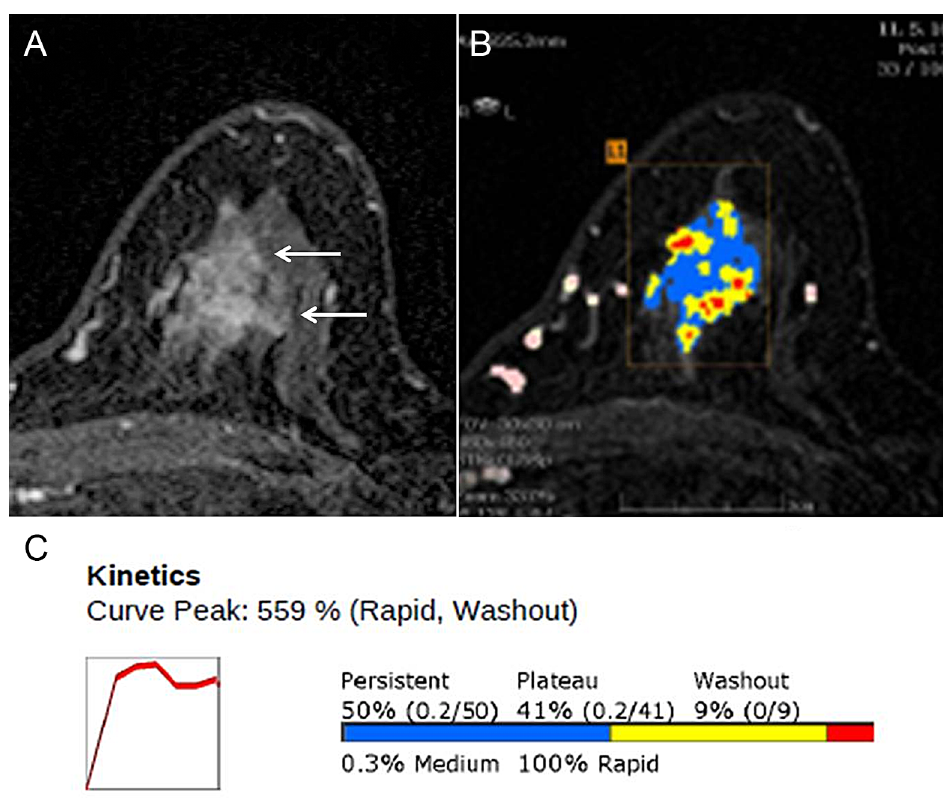
Fig 1. Magnetic resonance (MR) images with computer-aided detection (CAD) Color Overlay Map in a 66-year- old Woman with grade 2 invasive ductal carcinoma in the left breast. ( A ) Axial contrast-enhanced T1-weighted MR image shows a 26-mm irregular mass (arrows). ( B ) Axial maximum-intensity-projection MR image shows CAD color overlay over the breast mass. L1 denotes the first lesion of the left breast. Areas in red, yellow, and blue indicate a rapid washout-type delayed enhancement, plateau-type delayed enhancement, and persistent-type delayed enhancement pattern, respectively. (C) Kinetic curve graph showing rapid initial enhancement and rapid washout-type curve. The initial peak enhancement value was 559%. With respect to the delayed phase enhancement, 9% of the mass showed washout, 50% of the mass showed a persistent-type curve, and 41% showed a plateau-type curve. Regional recurrence was diagnosed in the ipsilateral axillary lymph node 26 months after